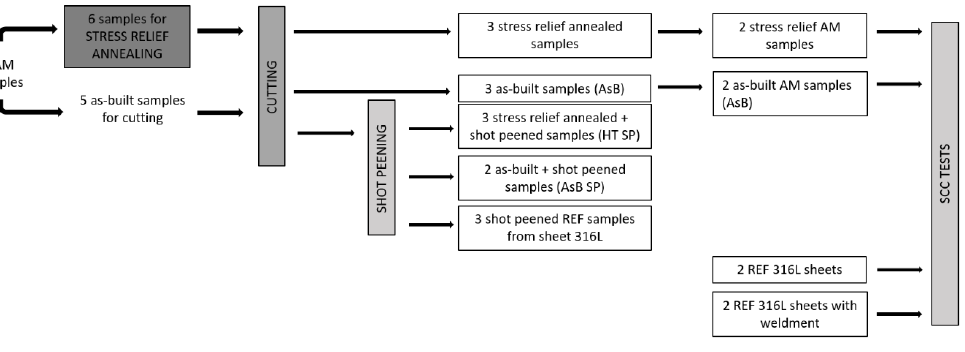
Figure 2. Process chart of samples.